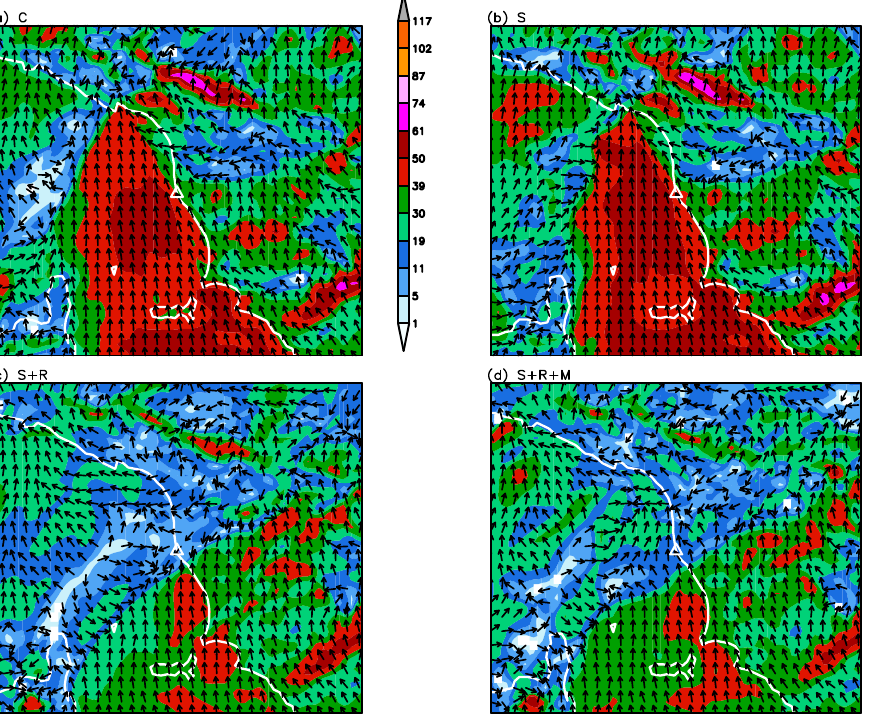
Figure 10. Ten-meter wind speed (unit km · h − 1 ) and direction at 0000 UTC, 10 September for ( a ) control run C , ( b ) assimi- lated run S , ( c ) assimilated run S + R , ( d ) assimilated run S + R + M . The white triangle indicates the Livorno